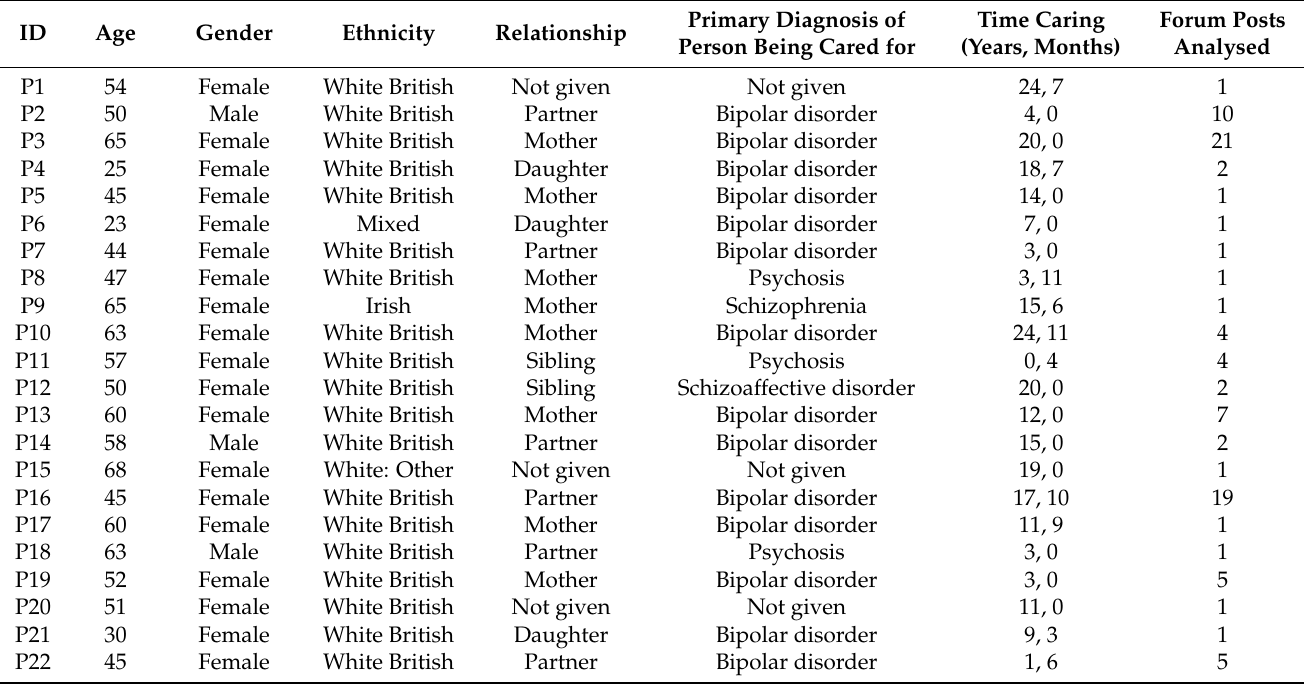
Table 1. Forum user demographic